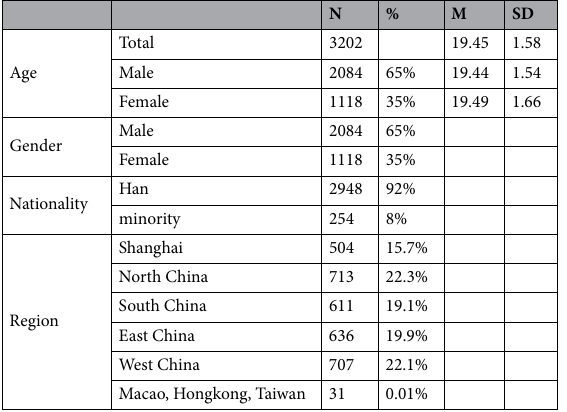
Table 1. Demographic of